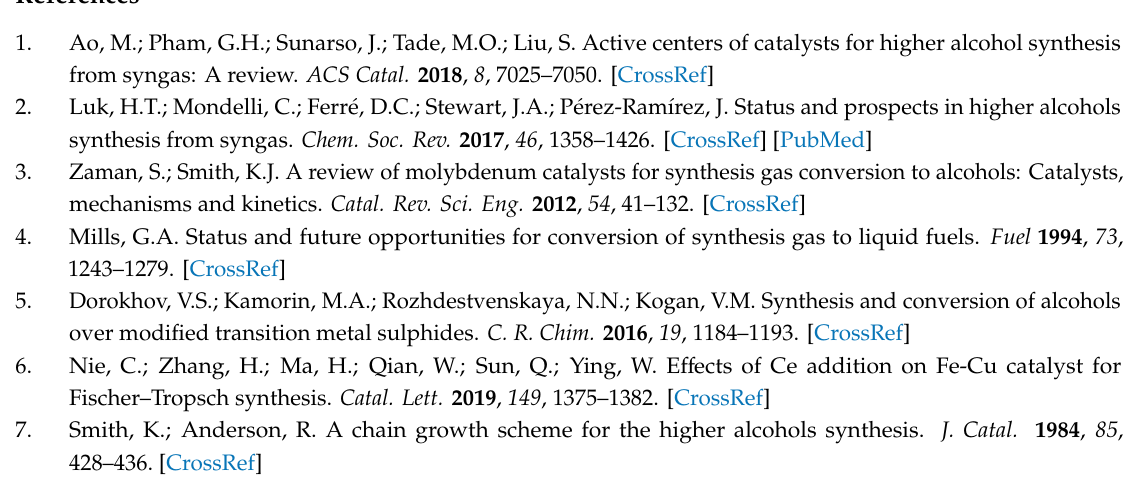
Figure S1: FESEM images of Mn-Ce mixed oxides nanorods: (a) 1.2MnCe, (b) 2.4MnCe, (c) 3.6MnCe, and TEM image of fresh catalyst: (d) CuFe / 2.4MnCe, Figure S2: XRD patterns: (a) xMnCe, (b) CuFe / xMnCe as synthesized, Figure S3: XRD patterns of catalysts CuFe / xMnCe after reaction, Table S1: BET and ICP results of fresh catalysts and the comparison with experimental